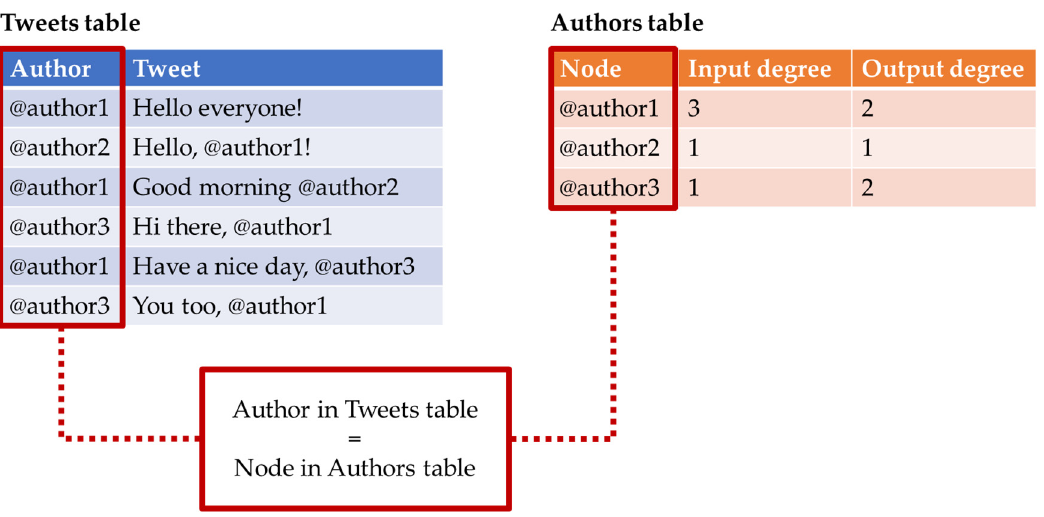
Figure 2. Example of combining data from two different tables. Source: Own elaboration with Power Point.